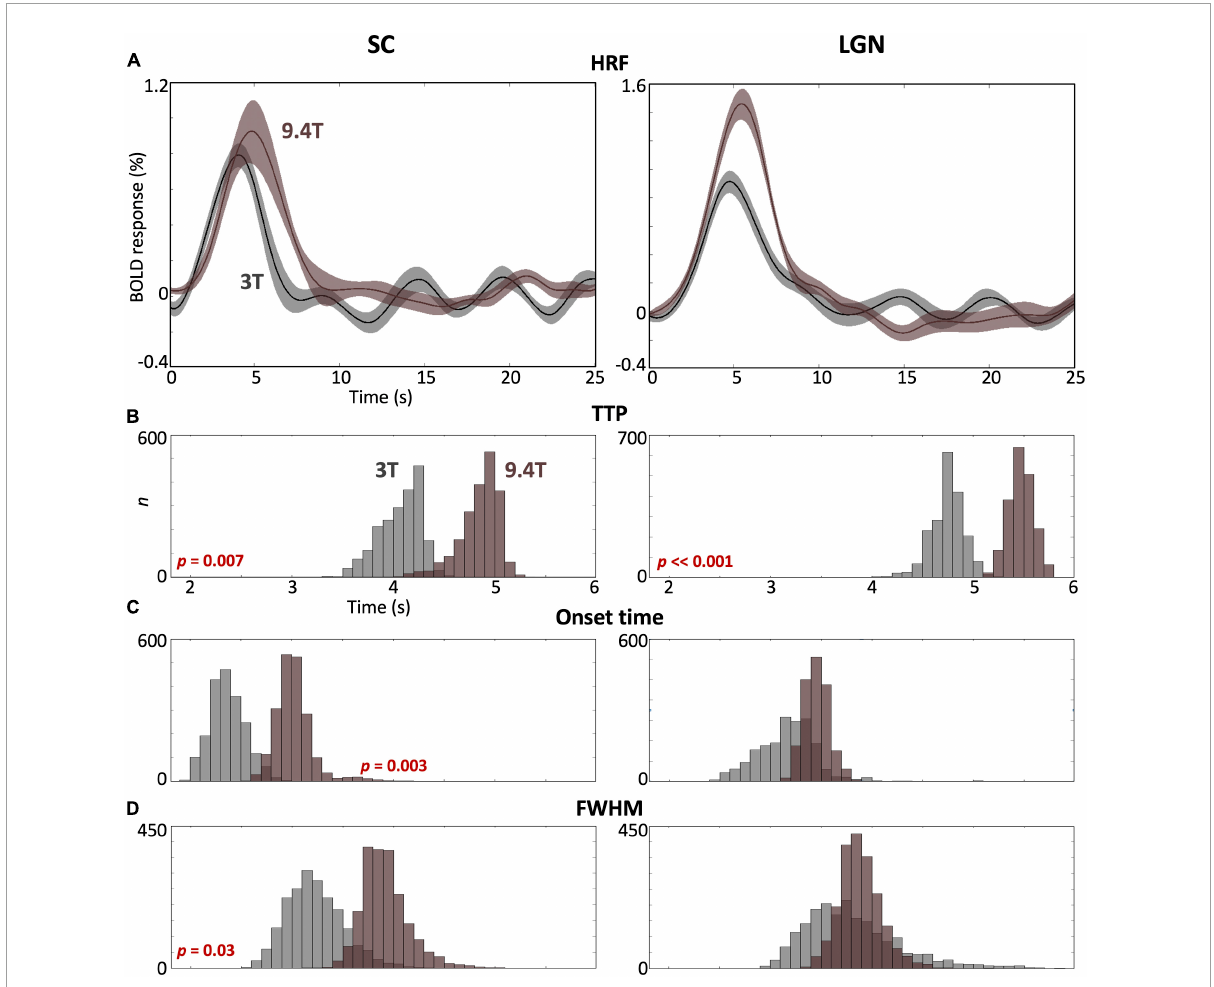
FIGURE5 (A) Comparison of the mean HRF (solid) with 68% confidence intervals (shaded region) across subjects in SC and LGN between 3T (gray) and 9.4T (brown). (B–D) Bootstrapped histograms show HRF temporal parameter differences between field strengths with p -values. In SC, all parameters show significant differences at p ≤ 0.03. In LGN, only TTP shows a significant